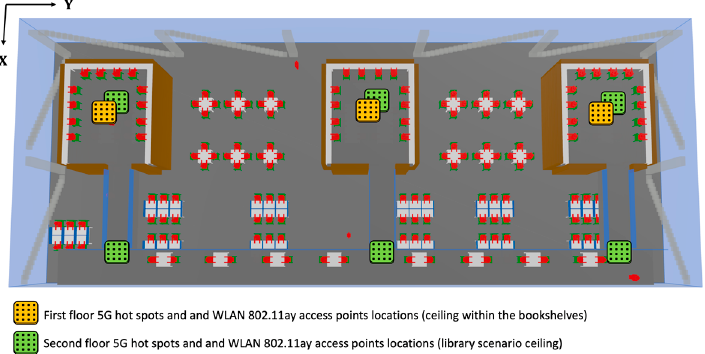
Figure 5. The 5G hot spots and WLAN 802.11ay access points locations co-sited with the current Wi- Fi access points in the scenario under consideration.